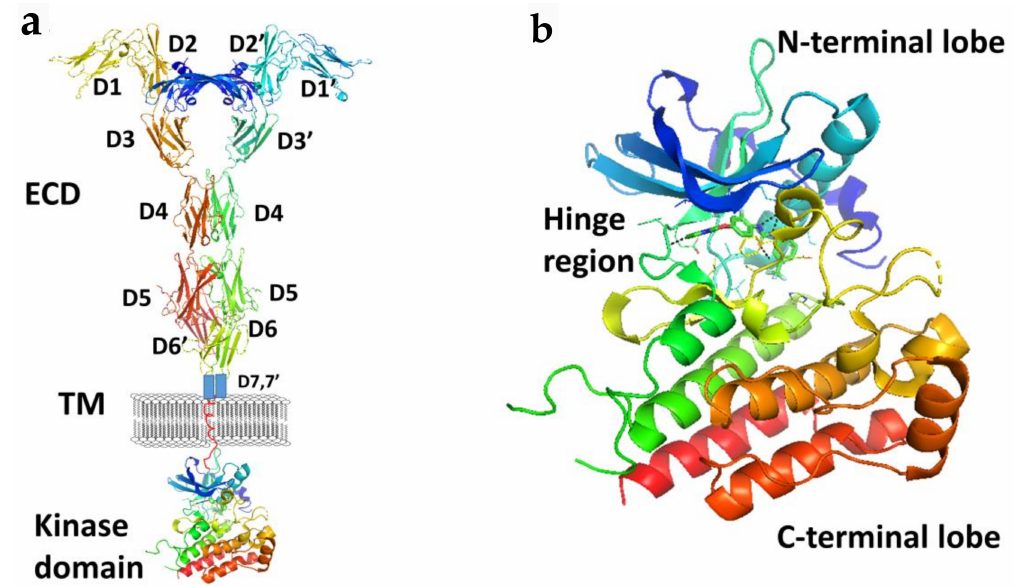
Figure 3. ( a ) A schematic representation of full length VEGFR-1 with VEGF-A. Extracellular domains D1 to D6 are from the crystal structure of VEGFR-1 (PDB ID: 5T89). D7 and TM are shown in schematic. Kinase domain was from the crystal structure of VEGF (PDB ID: 3VHE). ( b ) Kinase domain of VEGF (PDB ID: 3VHE) showing hinge region and N and C-terminal lobes. PyMol (Schrodinger LLC. OR) was used to generate the figure